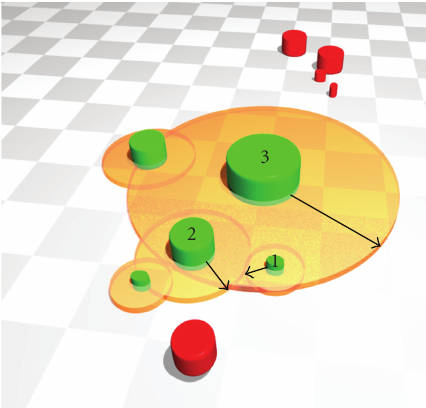
Figure 1: Hypothetical landscape with occupied (green) and unoccupied (red) forest patches in an agricultural matrix. Orange rings around occupied patches cover area likely to receive colonists. Arrows indicate threshold distance between surrounding occupied and unoccupied habitat patches. Geographical range is the union of these rings and all forest patches they